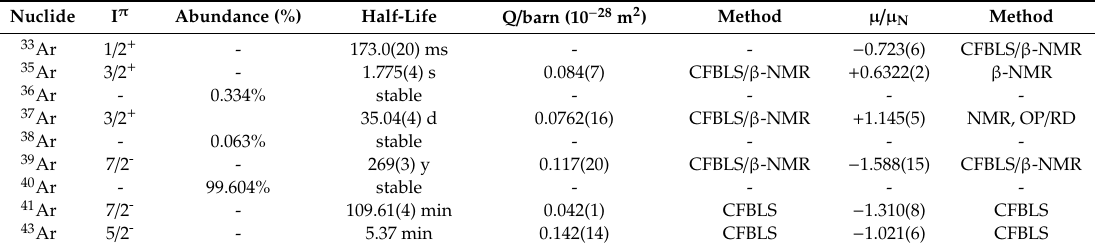
Table 4. Argon nuclides and their physicochemical properties